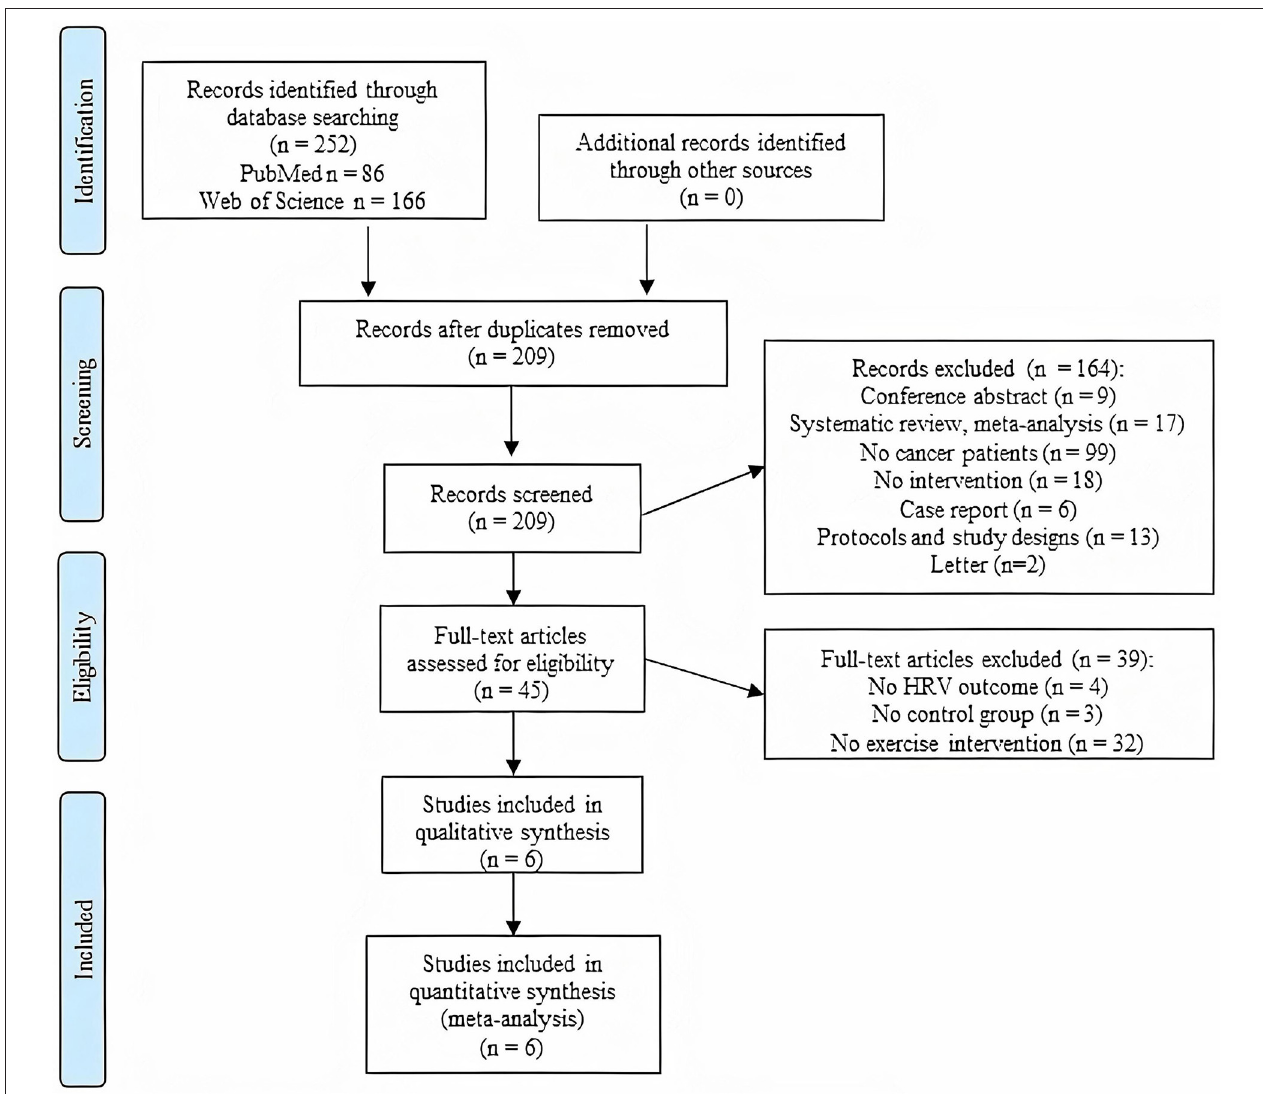
FIGURE 1 | Study flow diagram following the preferred reporting items for systematic reviews and meta-analyses